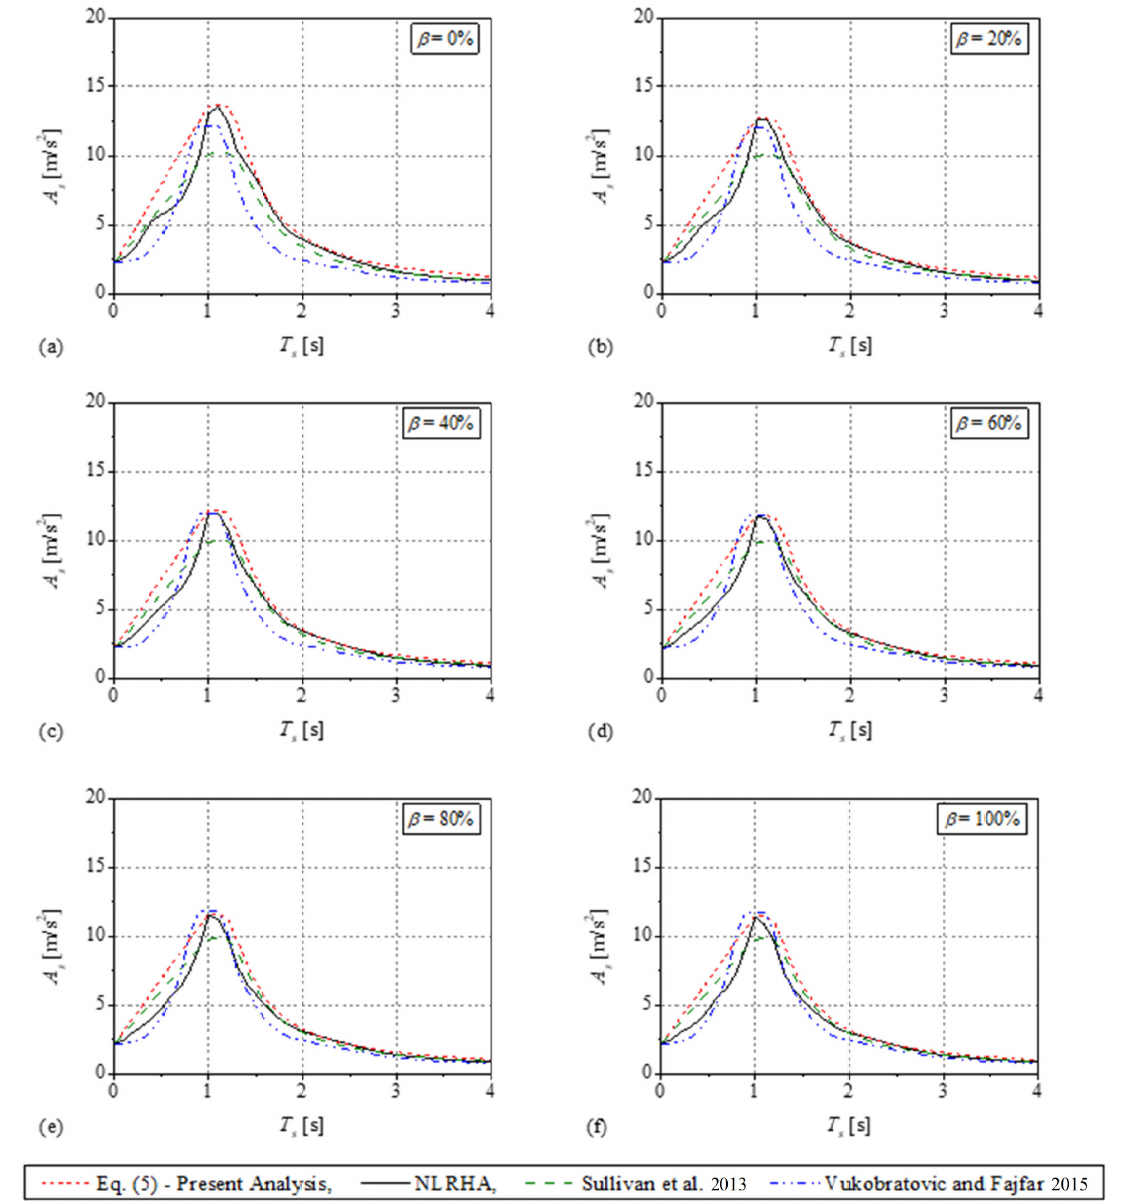
Figure 10. Comparison of the mean floor response spectra from Equation (5) of the present analysis, Sullivan et al. [8], Vukobratovic and Fajfar [14], and NLRHA for a primary structure with initial vibration period T p = 1.0 s, response reduction factor R = 2; post-yield stiffness ratio α = 5%; viscous damping ratio ξ p = 5%; and a secondary structure with viscous damping ratio ξ s = 5%: ( a ) β = 0%; ( b ) β = 20%; ( c ) β = 40%; ( d ) β = 60%; ( e ) β = 80%; and ( f ) β = 100%. Note: The methods of Sullivan et al. [8] and Vukobratovic and Fajfar [14] are for primary structures with modified Takeda and elasto-plastic hysteretic behavior,